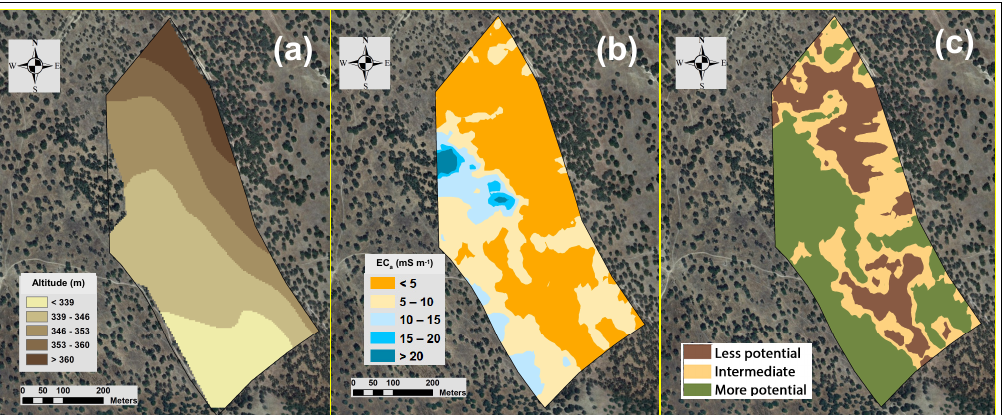
Figure 10. Altitude ( a ), soil apparent electrical conductivity (EC a ; ( b )) and homogeneous management zones ( c ) of “Padres” experimental field.